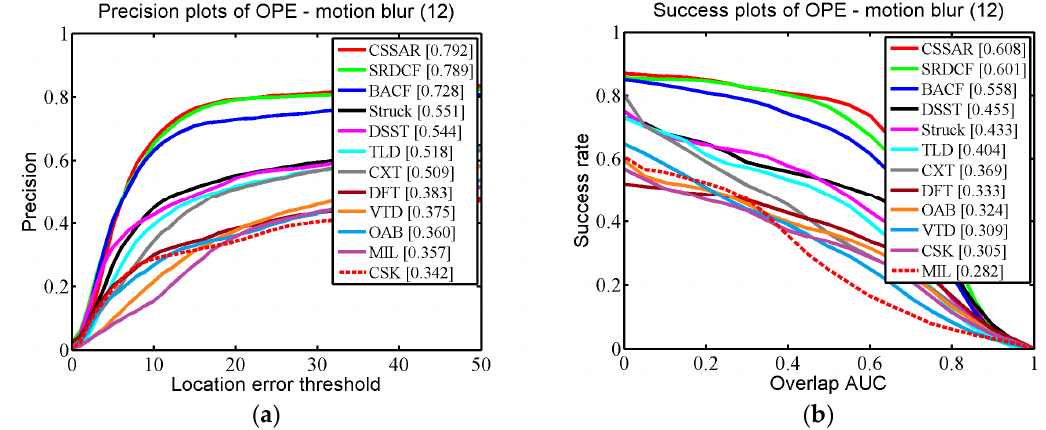
Figure 7. ( a , b ) respectively report precision and success plots on some representative sequences where the target region is blurred due to the motion of target or camera.